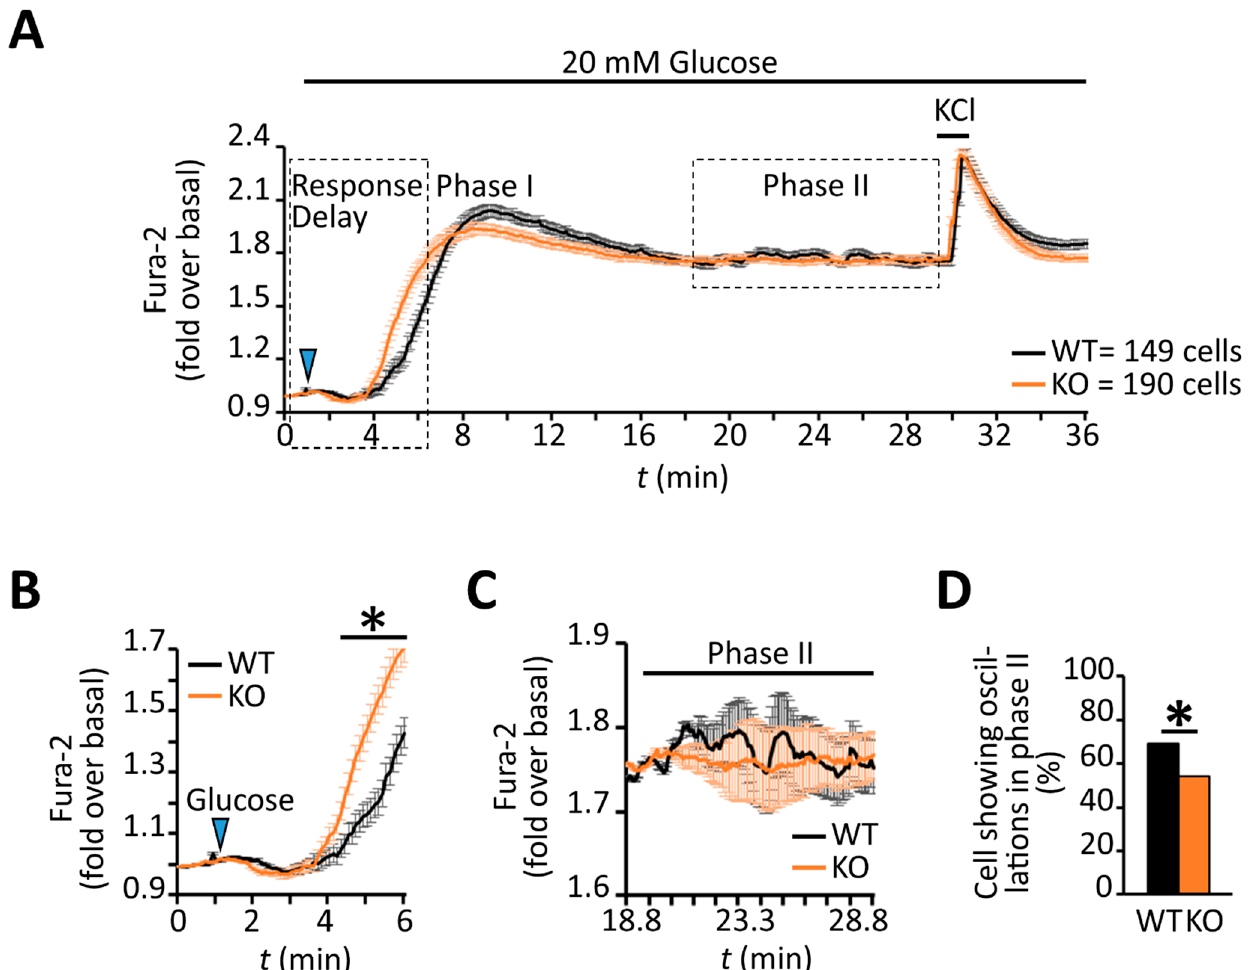
Figure 7. RGS4-deficient β -cells show altered intracellular calcium responses to glucose stimulation. ( A ) Kinetic profile of the glucose-stimulated intracellular calcium response was recorded by fluorescent ratiometric imaging of dispersed β -cells from WT and RGS4-KO pancreata loaded with Fura-2 calcium indicator dye. Panel ( B ) highlights the intracellular calcium kinetics in the early phase (phase I) of the response to glucose challenge. Panel ( C ) highlights the intracellular calcium dynamics in the later phase (phase II) response to glucose, a phase normally associated with oscillatory intracellular calcium and insulin secretion behavior. ( D ) Relative quantitation of the percentage of β -cells showing phase II intracellular calcium oscillations in WT and RGS4-KO mice. * p < 0.05; [ t -test ( B ), Fisher test ( D )].